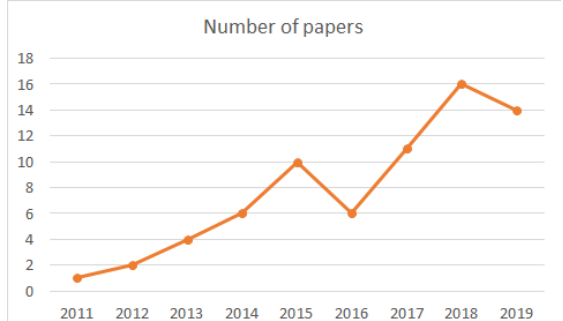
Figure 2. Distribution of selected papers over time. The horizontal axis shows the publication years. The vertical axis shows the number of papers published per